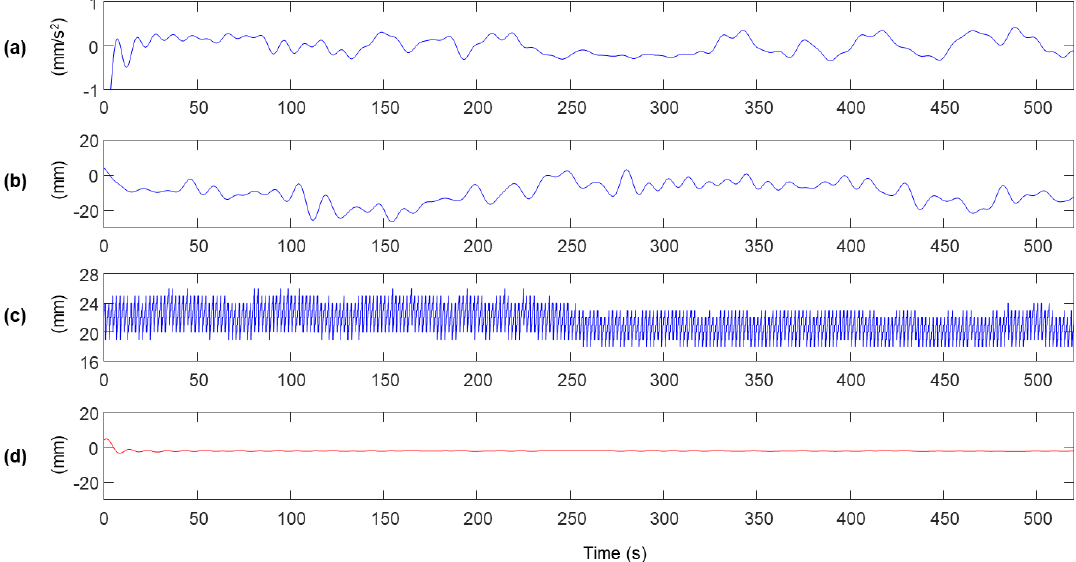
Figure 6. Measurements filtered out with a lowpass filter with 0.1 Hz cutoff frequency: ( a ) 𝑥̈ 𝑙𝑎 (𝑘) , ( b ) 𝑥 𝑙𝑟 (𝑘) , ( c ) 𝜎 𝑚𝑟 (𝑘) , and ( d ) 𝑥 𝑙 (𝑘) Figure 7 compares 𝑥̂ 𝑙𝒂 (𝑘) and 𝑥̂ 𝑙𝒓 (𝑘) , displacements estimated